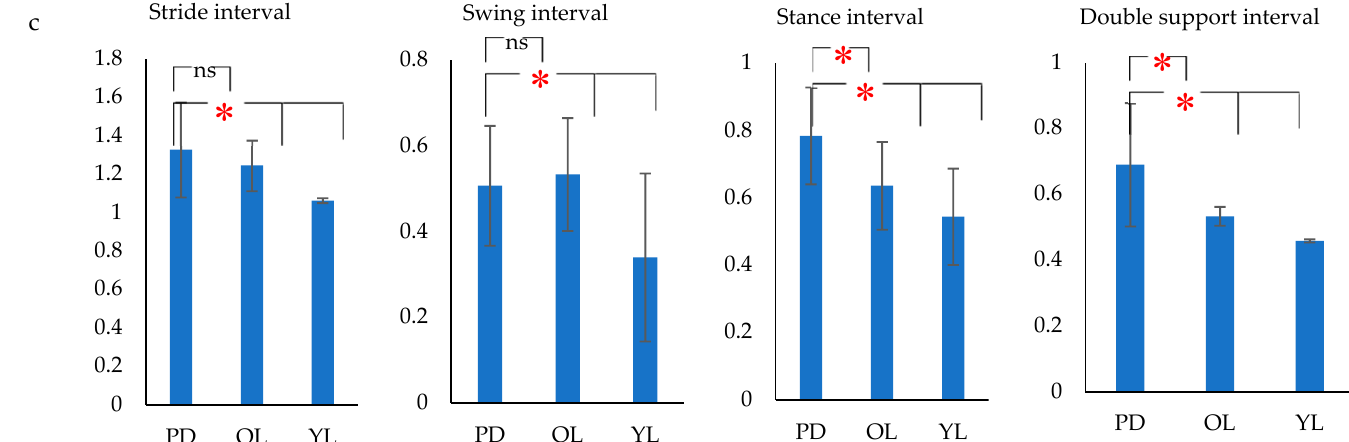
Figure 7. Bar charts showing mean (SD) stride interval, swing interval, stance interval and double support interval for PD, OL and YL subjects for ( a ) Straight walking ( b ) Turn around a point ( c ) U ‐ turn (* p (Significance) < 0.05, ns (non ‐ significant)).